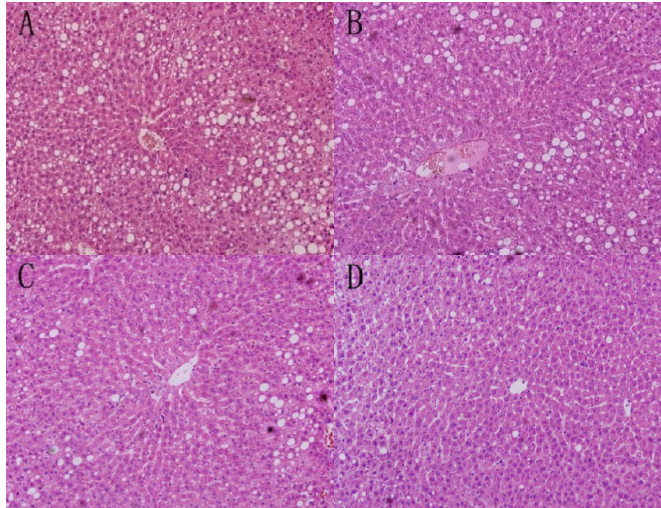
Figure 1. Liver sections stained with haematoxylin and eosin (original magnification ×200) from each